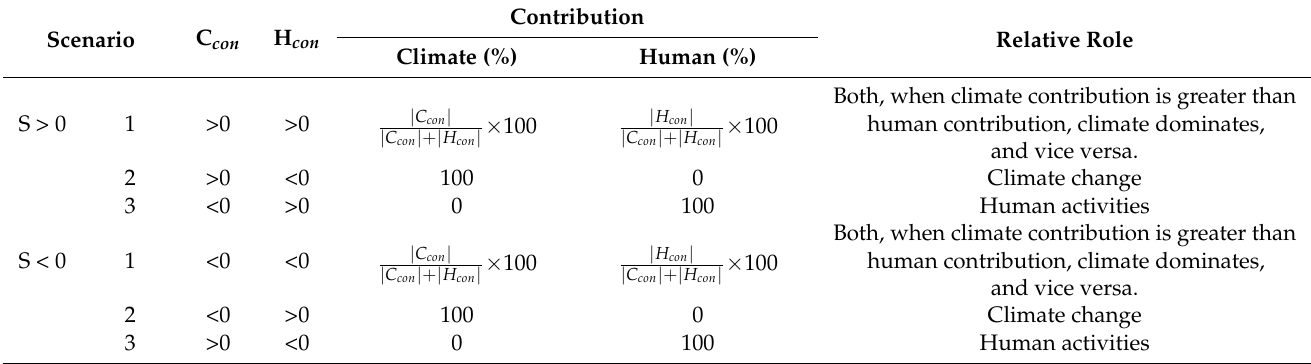
Table 1. Six scenarios for quantifying the contribution proportions of climate and humans to F new of restoration and degradation. Scenario